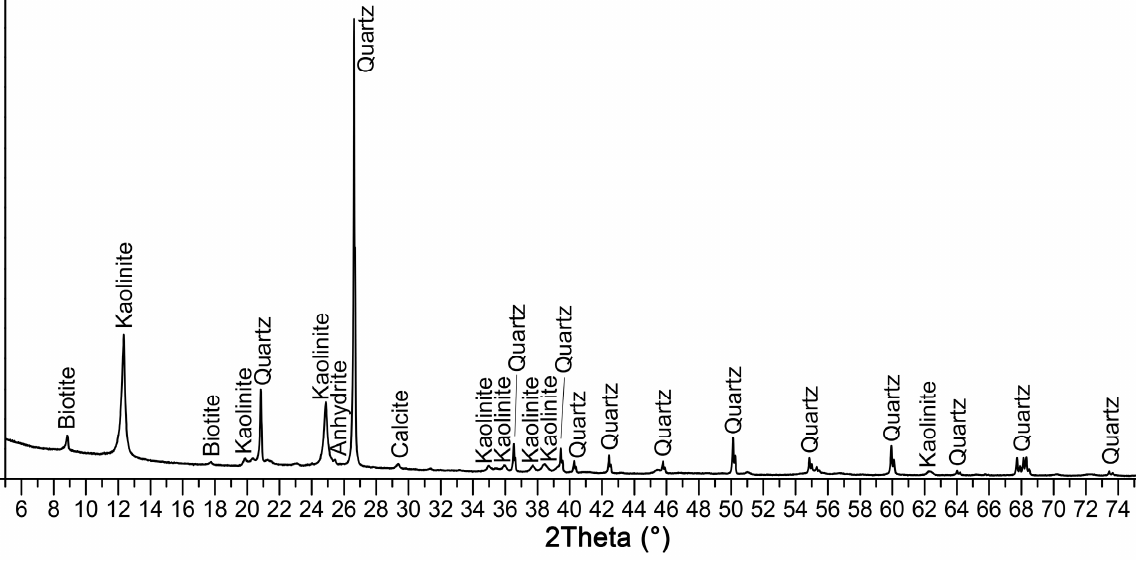
Figure 7. X-ray diffraction pattern of dried KQF green body.